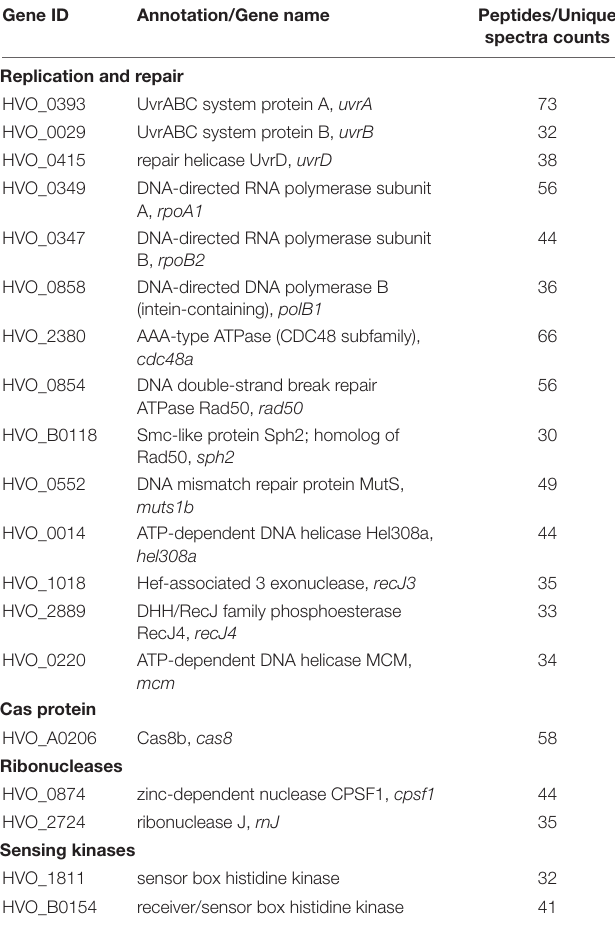
TABLE 3 | Proteins that were co-purified with Cas1.